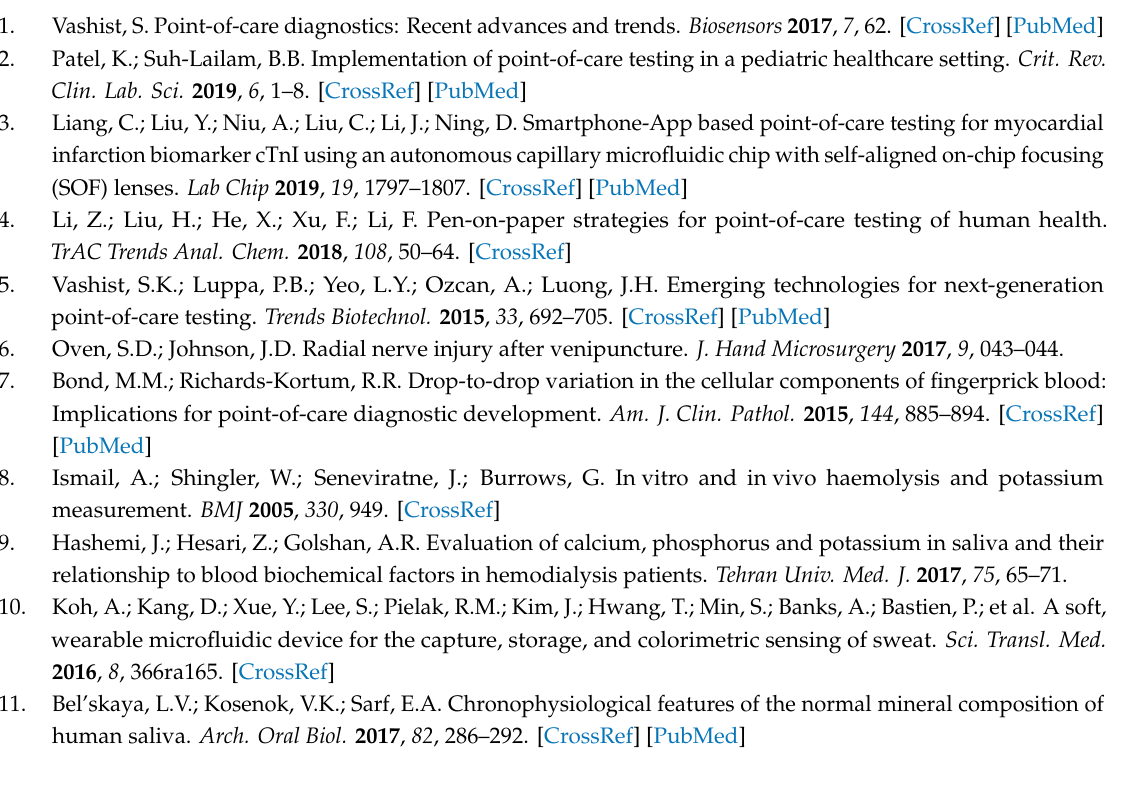
Figure S1: ( A ). (i) Time varying optical absorbance of a saliva sample mixed with chromogenic agent measured on-chip using the hybrid integrated device. The mean optical absorbance value was ~2.36 (ii) Optical absorbance measurement of the same sample measured using a UV / Vis spectrophotometer showing the absorbance value at 450 nm ~2.4. ( B ). Preparation of water in oil emulsion: Finer dispersion of water (blue) in the colorless oil medium throughout the chamber is observed with the actuation of the micromixer. Much longer micromixing time (~600 s) was required to achieve this, Figure S2: Enlarged versions of Figure 2E, Figure